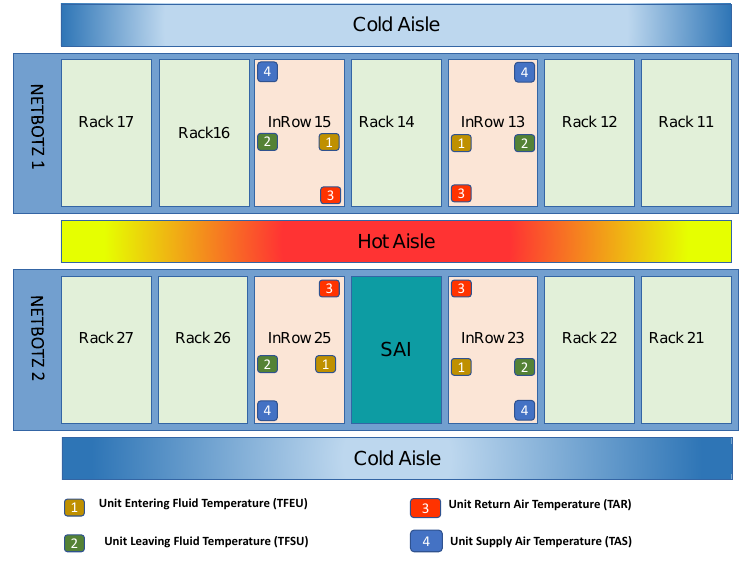
Figure 1. Physical